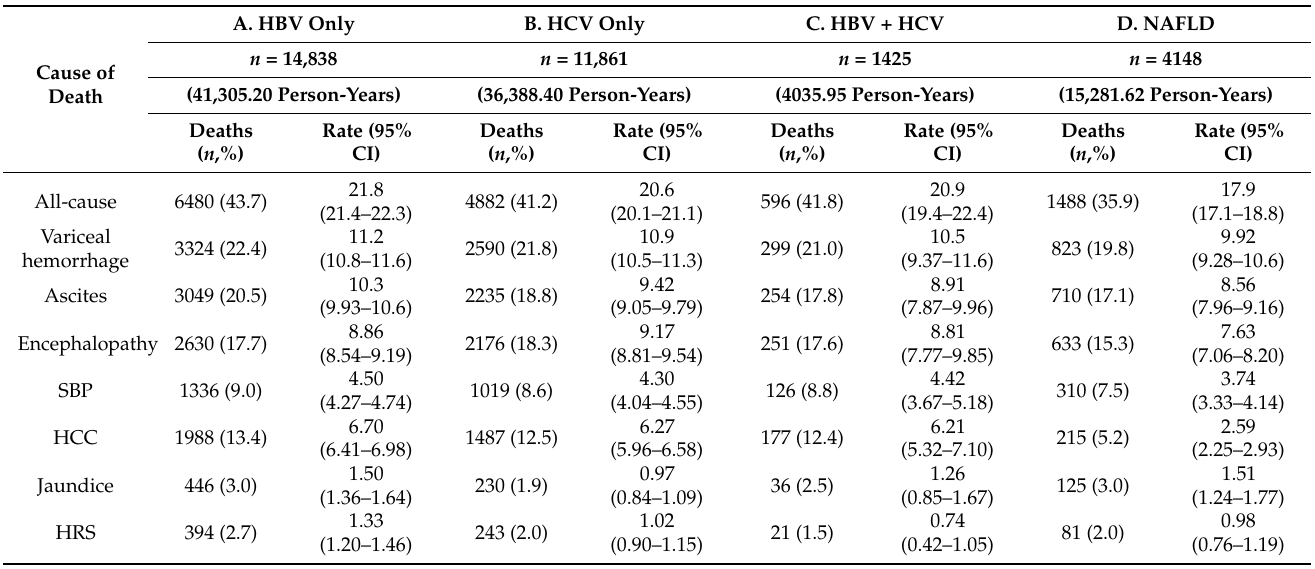
Table 3. Crude mortality rates per 100 person-years for non-alcoholic liver cirrhosis patients by etiology.